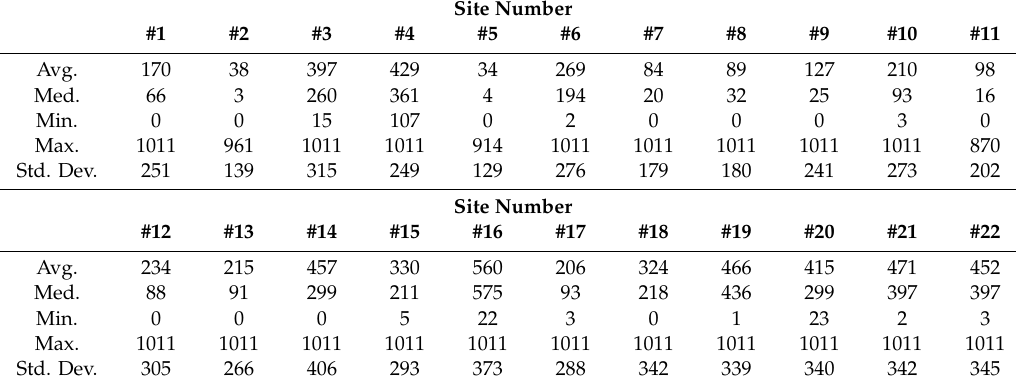
Table A1. Descriptive statistics of E. coli concentration (CFU per 100 mL) at each sampling location (n = 22) during study period (2 January 2018–1 January 2019) in West Run Watershed, WV, USA. Avg. = average, Med = median, Min. = minimum, Max. = maximum and Std. Dev. = standard deviation.